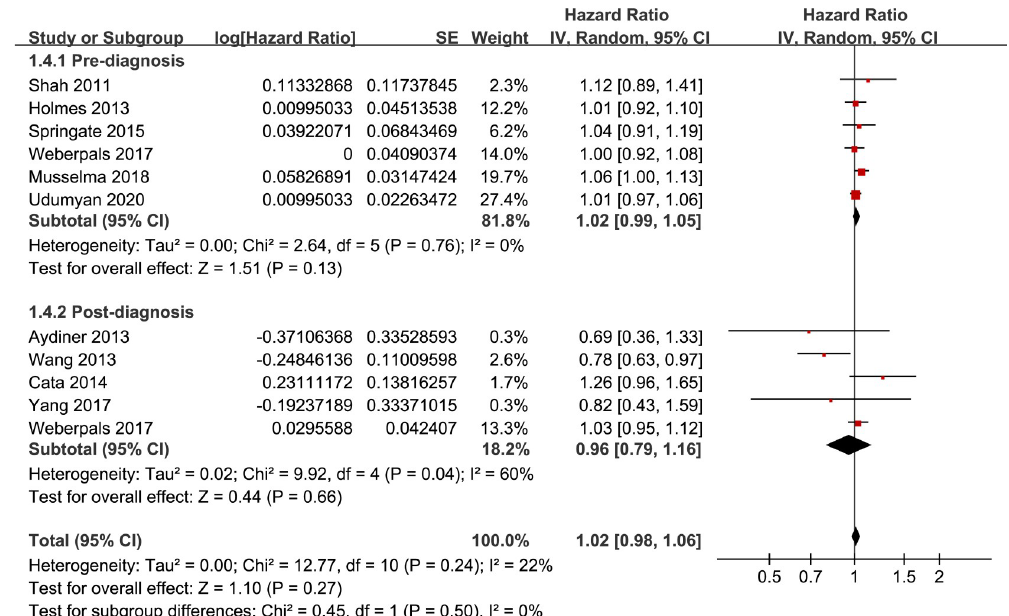
Fig 6. Stratified analyses for the meta-analysis of the association between BB use and OS of lung cancer according to the timing of BB use.